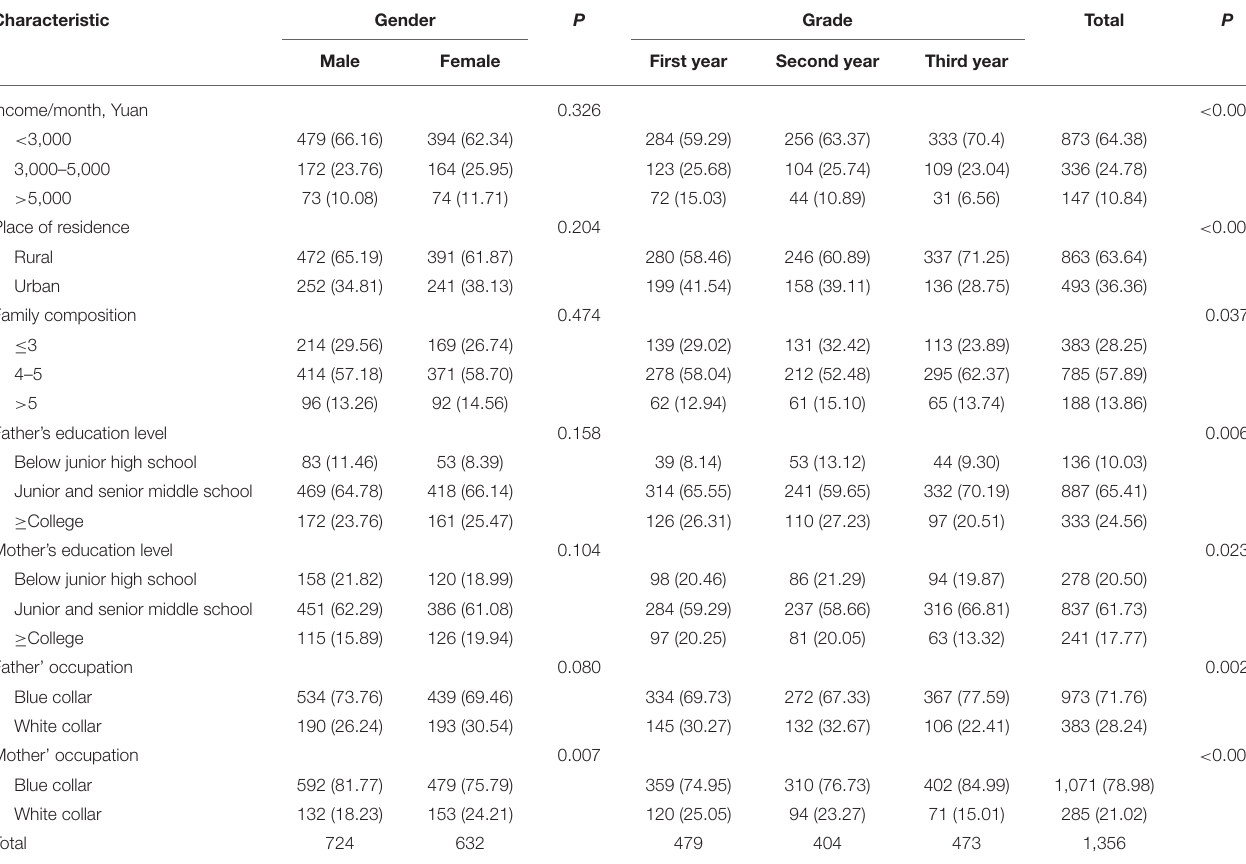
TABLE 1 | Demographic characteristic of participants of different genders and with different grades [ n (%)]. Characteristic Gender P Grade Total P Male